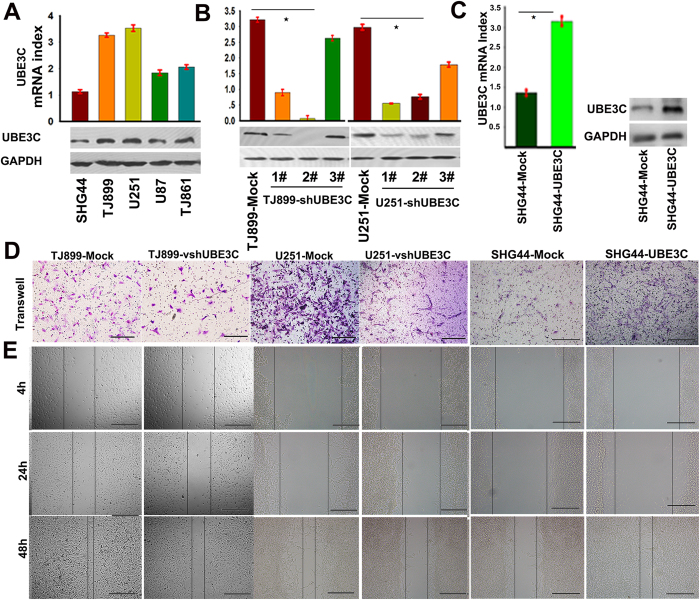
UBE3C interference decreased the migration and invasion of TJ899/U251 cells.RT-PCR and immunoblotting analyzed the expression of UBE3C in SHG44, U251, U87, TJ861 and TJ899 cells; (B and C) The expression of UBE3C were regulated in TJ899 and U251 cells by RNA interference; (D) Matrigel invasion assays showed that down-regulation of UBE3C was accompanied by a descend invasion of gliomas cells(bar = 100μm); (E) The scratch assay revealed that an conspicuous delay in the wound closure rate of TJ899/U251-vshRNA-UBE3C cells was found at 24 and 48h, compared with TJ899/U251-Mock cells(bar = 100 μm).